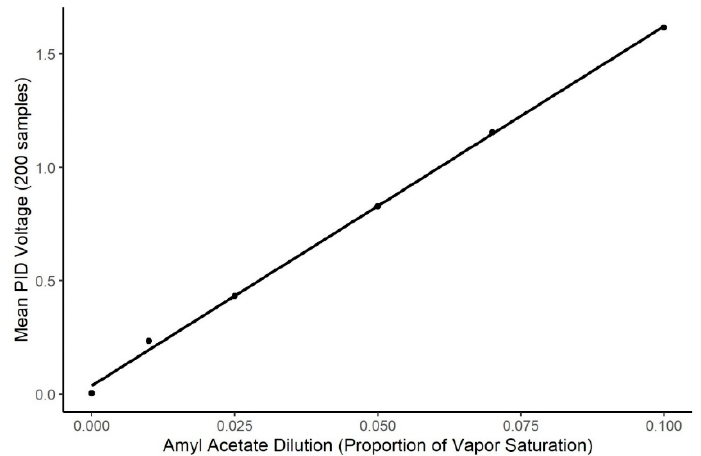
Figure 2. Calibration of Air Dilution Olfactometer. Figure shows the systematic change in the Photo Ionization Detector output as a function of systematic changes in the air dilution olfactometer (R 2 = 0.998). X -axis shows the air dilution in effect on the olfactometer and Y -axis shows the change in sensor output.